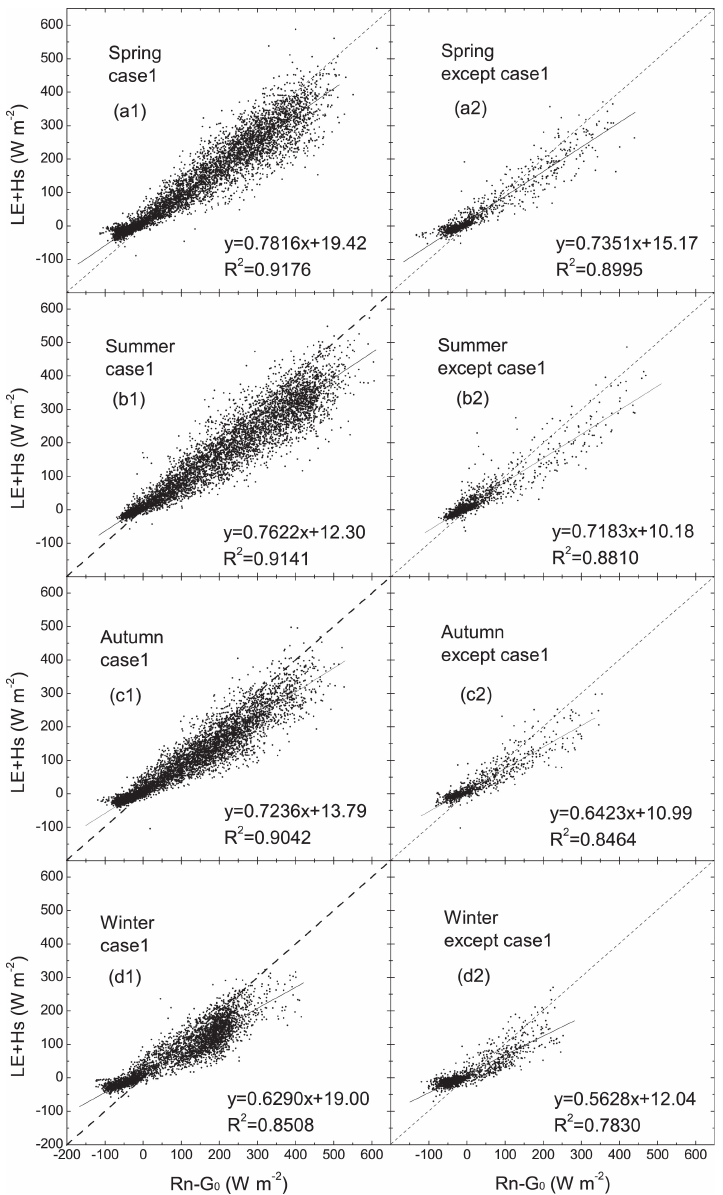
Fig. 11. Seasonal effect of the low-frequency part of the turbulence spectra on EBC at SACOL site. Here, G 0 is calculated with PlateCal approach. (a1) data of Case 1 for Og wT and Og wq in spring; (a2) data without Case 1 for Og wT and Og wq in spring; (b1) same as (a1) but in summer; (b2) same as (a2) but in summer; (c1) same as (a1) but in autumn; (c2) same as (a2) but in autumn; (d1) same as (a1) but in winter; (d2) same as (a2) but in